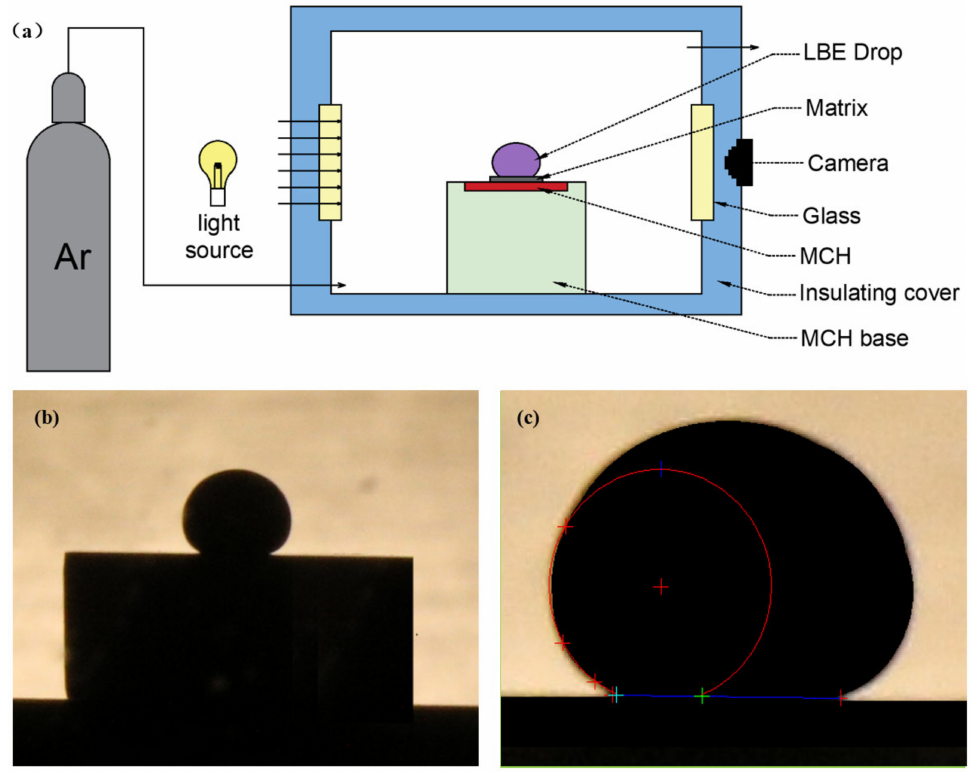
Figure 1. ( a ) Measurement of contact angle. ( b ) Side view. ( c ) Five-point fitting measurement